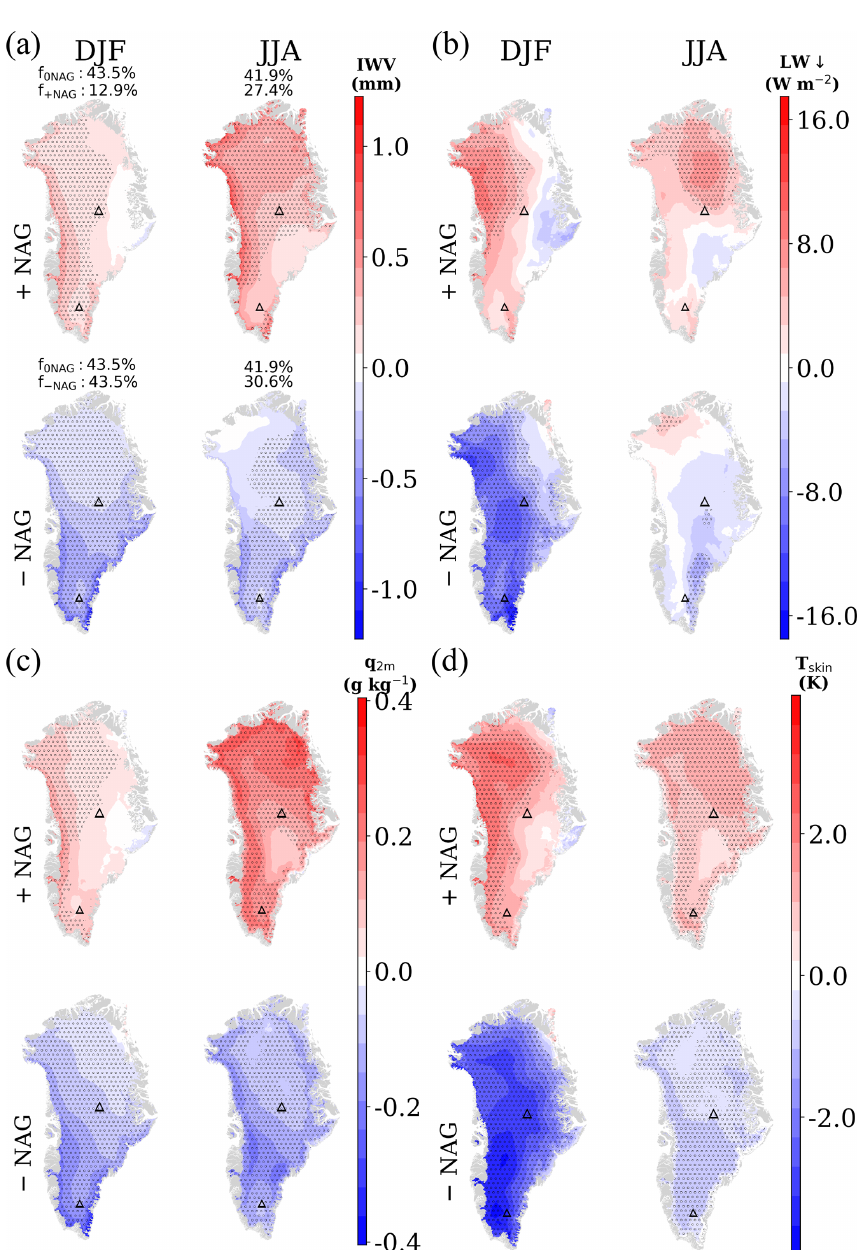
Figure 4. Seasonal and spatial anomalies for (a) integrated water vapor (IWV), (b) incoming longwave radiation at the surface (LW ↓ ), (c) spe- cific humidity at 2m ( q 2m ) and (d) skin temperature ( T skin ) for opposite NAG phases with respect to the neutral phase ( + ( − ) NAG − 0NAG) between 1959 and 2020 from RACMO2. The relative seasonal frequency ( f in %) of each NAG phase ( + NAG, 0NAG and − NAG) used to produce composites is indicated as a subtitle in (a) . For reference, Summit and South Dome are marked with big and small black triangles, respectively. Stippled regions indicate areas with a confidence level greater than 90% (based on the Wilcoxon rank-sum statistic test for unpaired sets). See Fig. S7 to examine seasonal and spatial anomalies in spring (MAM) and autumn